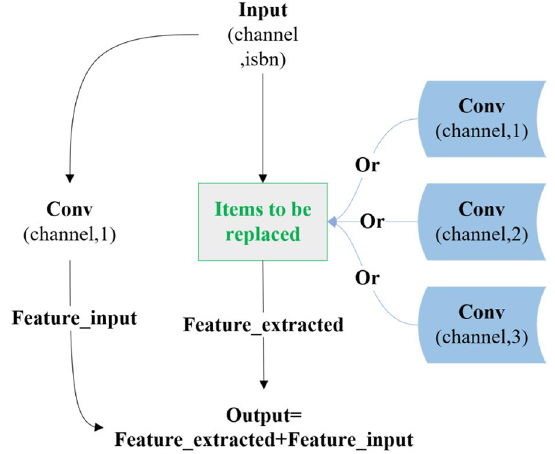
Fig. 9 Single convolution group for replacing CCB